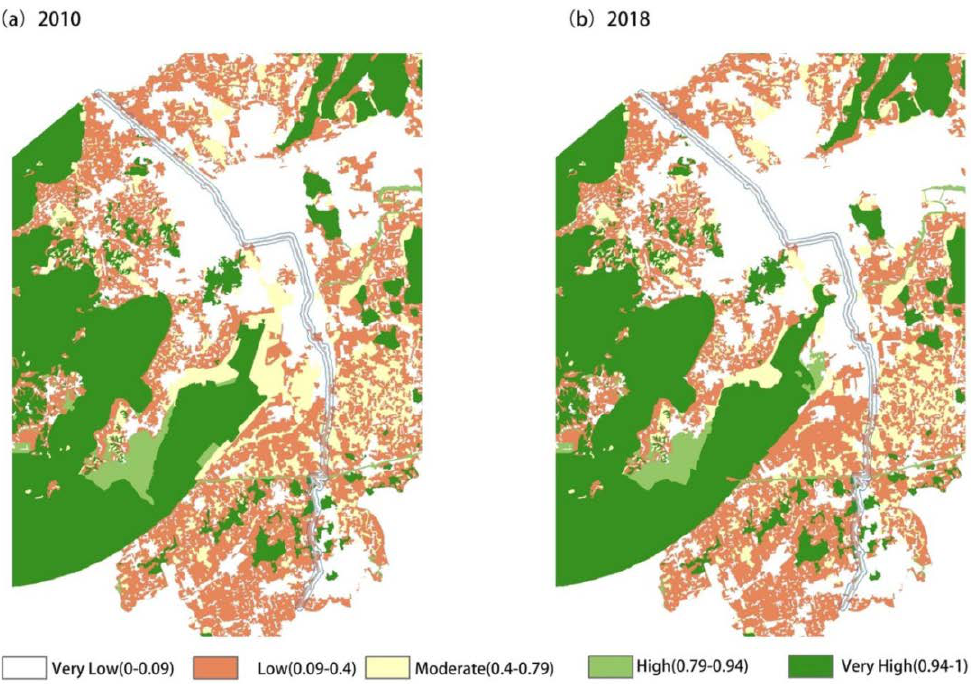
Figure 7. Habitat quality map of the study area between 2010 and 2018 (the middle section is mainly low-quality habitats, while the moderate and high-quality habitats are distributed in the upstream and downstream of the Suzhou section of the Grand